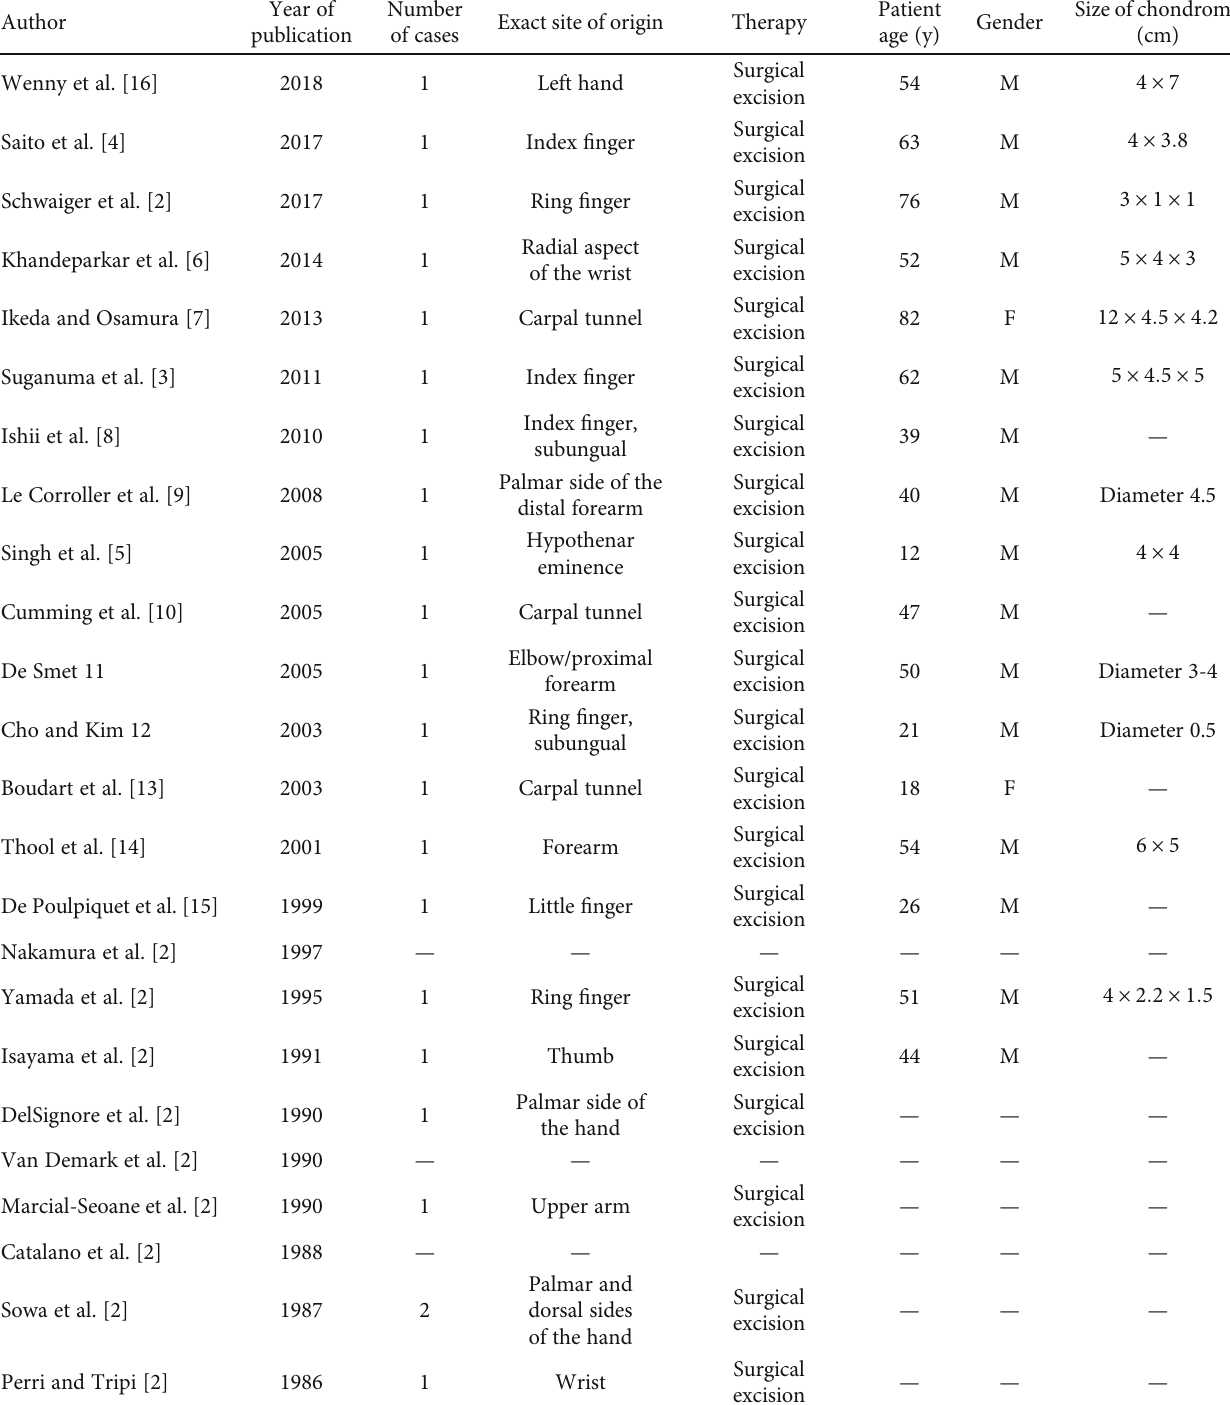
Table 1: Review of the published cases of EC a ff ecting the hand and upper